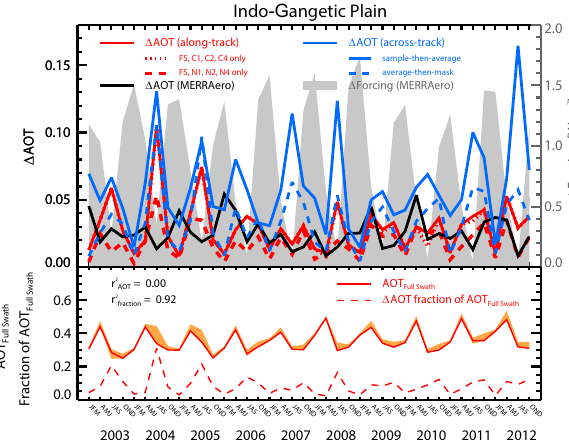
Figure 9. Seasonal–regional sampling artifacts 1 AOT and 1 forcing for South America. Red lines are the MODIS along-track 1 AOT sampling artifact using the average-then-mask approach (solid: all samples except C3 and N3; dotted: full swath, C1, C2, and C4 samples only; dashed: full swath, N1, N2, and N4 sam- ples only). Blue line is the MODIS across-track 1 AOT sampling artifact (solid for the “sample-then-average” approach, dashed for the “average-then-mask” approach). Black line is the along-track 1 AOT sampling artifact from the MERRAero results. Grey shading (corresponding to right-hand vertical scale) is the 1 forcing artifact from MERRAero results. Also shown are the MODIS full-swath mean AOT (bottom, solid line), the range of the along-track sub- sample AOT values about the full-swath mean (bottom, shading), and 1 AOT as a fraction of the full-swath AOT (bottom, dashed). Finally, we show the r 2 correlation coefficients between 1 AOT and the full-swath seasonal–regional mean AOT, as well as the 1 AOT as a fraction of the full-swath mean.